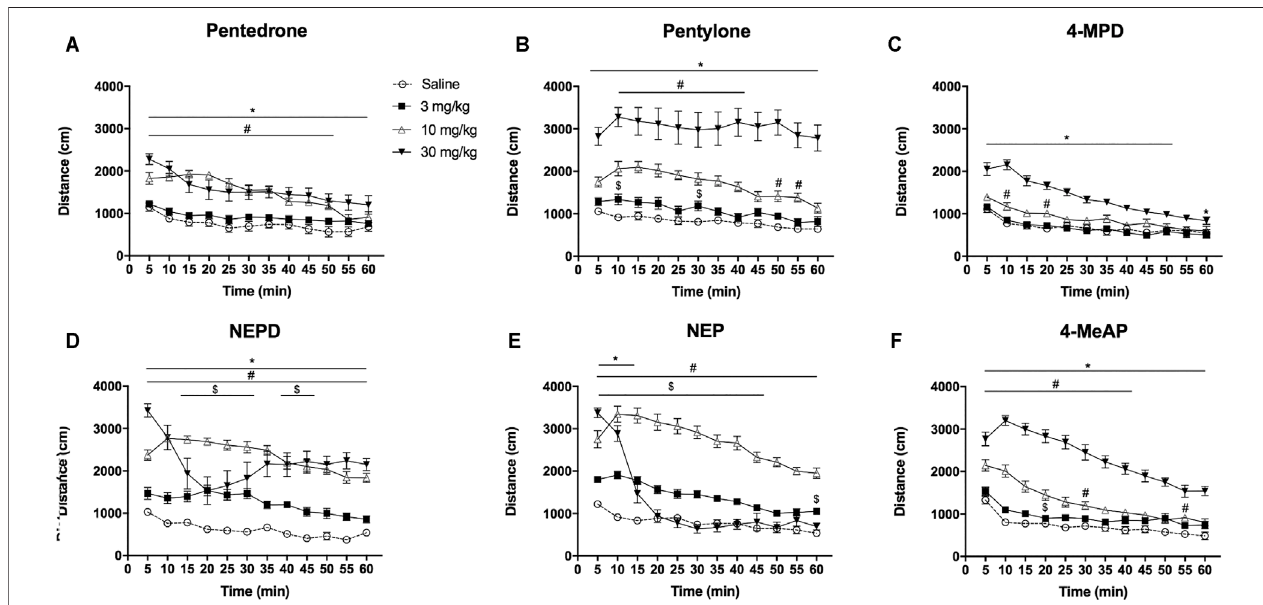
FIGURE5| Timecoursepro fi leofHLAinducedbypentedrone (A) ,pentylone (B) ,4-MPD (C) ,NEPD (D) ,NEP (E) ,and4-MeAP (F) .Eachtimepointrepresentsthe mean ± SEM of the distance (in cm) traveled in 5 min blocks. Only comparisons vs the corresponding saline group are shown for clarity purposes. Tukey ’ s multiple- comparisons test; * p < 0.05, 30 mg/kg dose group vs saline group; # p < 0.05, 10 mg/kg dose group vs saline group; $ p < 0.05, 3 mg/kg dose group vs saline group ( N (cid:2) 12 – 14/group).